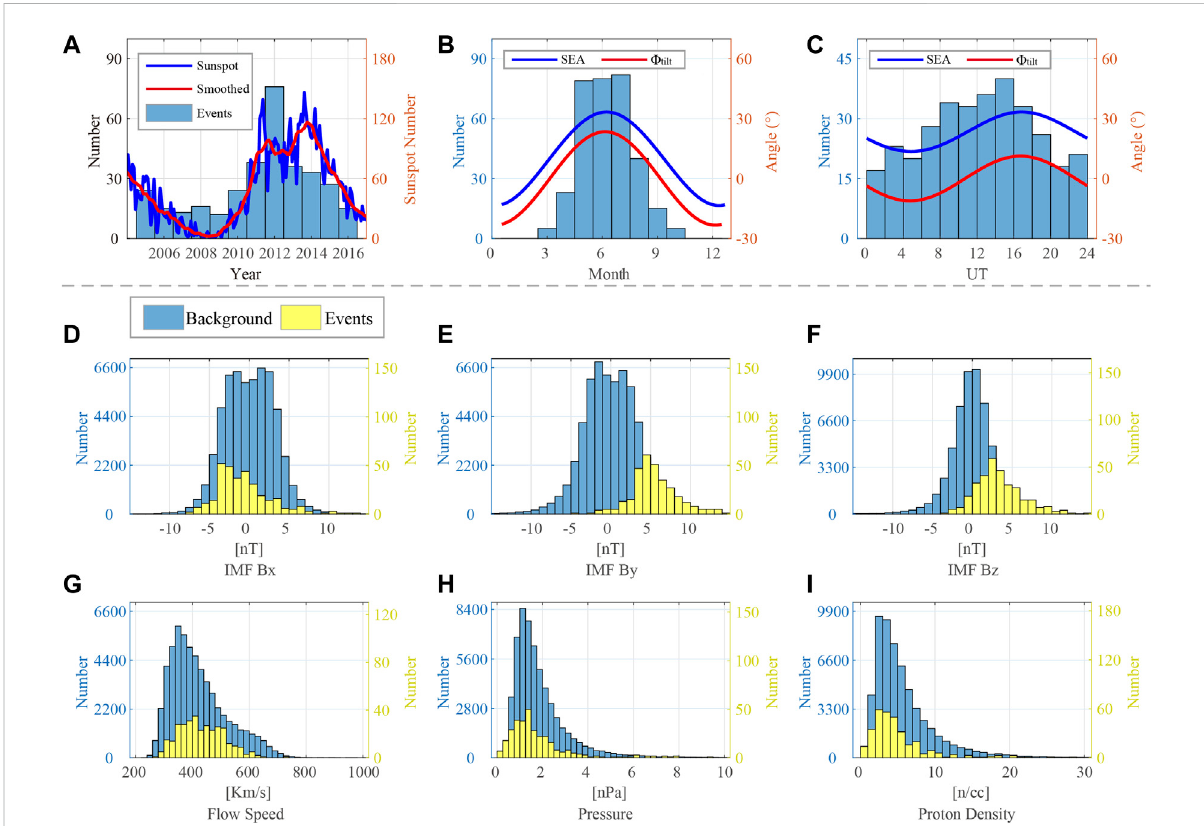
FIGURE 3 Dependence of the space hurricane observed by DMSP F16 from 2005 to 2016 on (A) years, (B) months, (C) universal time, (D – F) IMF (Bx, By, andBz),and (H – G) solar wind( fl owspeed, dynamicpressure, andprotondensity) conditions. In panel (A) , theblueandredcurvesshowthemonthly and monthly smoothed values of the sunspot number, respectively. In panel (B) , the blue curve shows the annual variations of the solar elevation angle at the magnetic north pole (72.2 ° W, 80.1 ° N), and the red curve shows the annual variations of the Earth ’ s dipole tilt angle. In panel (C) , the blue curve shows the diurnal variations of the solar elevation angle at the magnetic north pole on the summer solstice (June 21st), and the red curve shows the diurnal variations of the Earth ’ s dipole tilt angle. In panels (D – I) , the blue bars represent the background conditions and the yellow bars represent the conditions in space hurricane